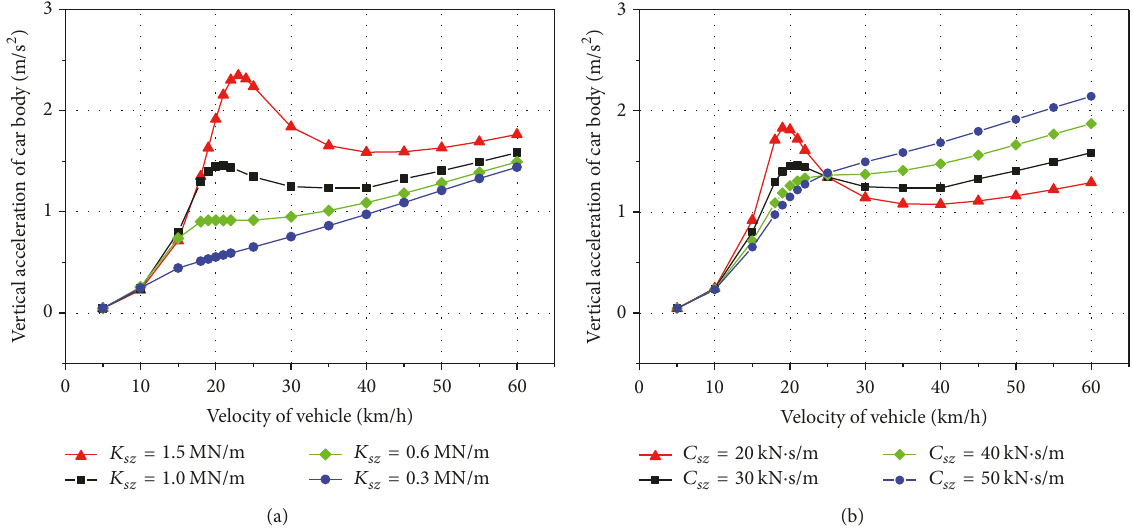
Figure 12: The effect of secondary suspension on the vibration of car body with wheel eccentricity: (a) stiffness and (b) damping.